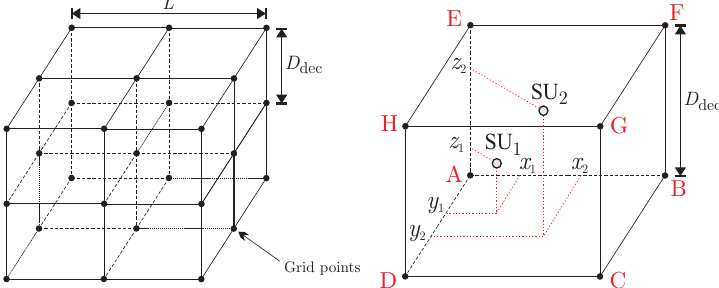
Figure 3. Pictorial representation of the three-dimensional correlated shadowing model: 3D space with L × L × L m 3 ( left ); zoomed single cube with D dec × D dec × D dec m 3 , with arbitrarily placed SU 1 and SU 2 ( right